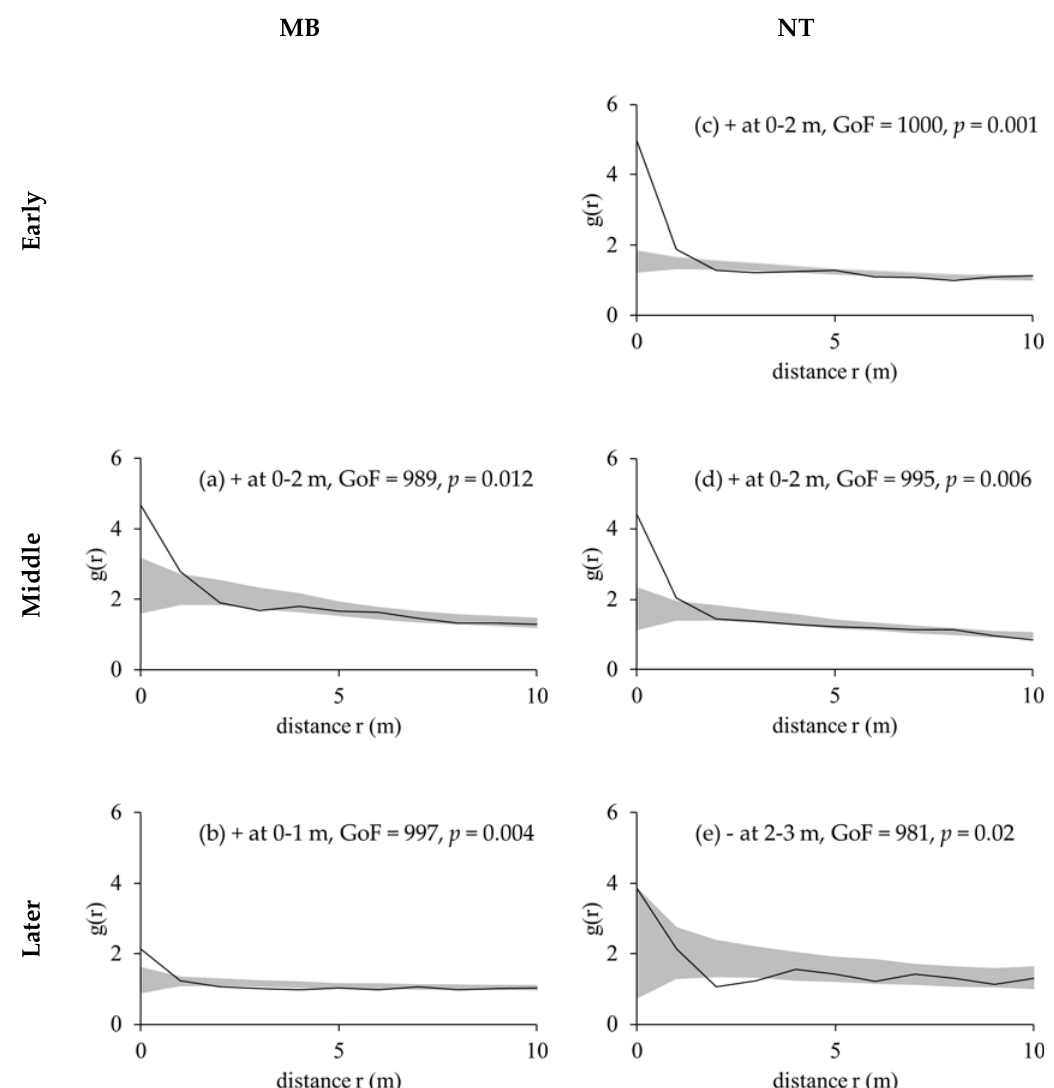
Figure 3. Pair-correlation functions of MB (moso bamboo, a , b ) and NT (native forest, c , d , e ) in different bamboo expansionary phases for all of nine plots (with the early, middle, and later phases each represented by three plots). Black solid lines denote the observed pair-correlation function. The envelopes (grey areas) denote the range of the pair-correlation function of a random spatial distribution pattern and were constructed using 99% quantiles of 999 Monte Carlo simulations based on the heterogeneous Poisson process null model. If the rank of the test was larger than 950 (990), the data showed a significant or extremely significant departure from the null model with an error rate a = 0.05 (extremely significant departure, a = 0.01). An aggregated or regular distribution pattern of points is implied if the observed curve lies above or below the simulation envelopes, respectively.